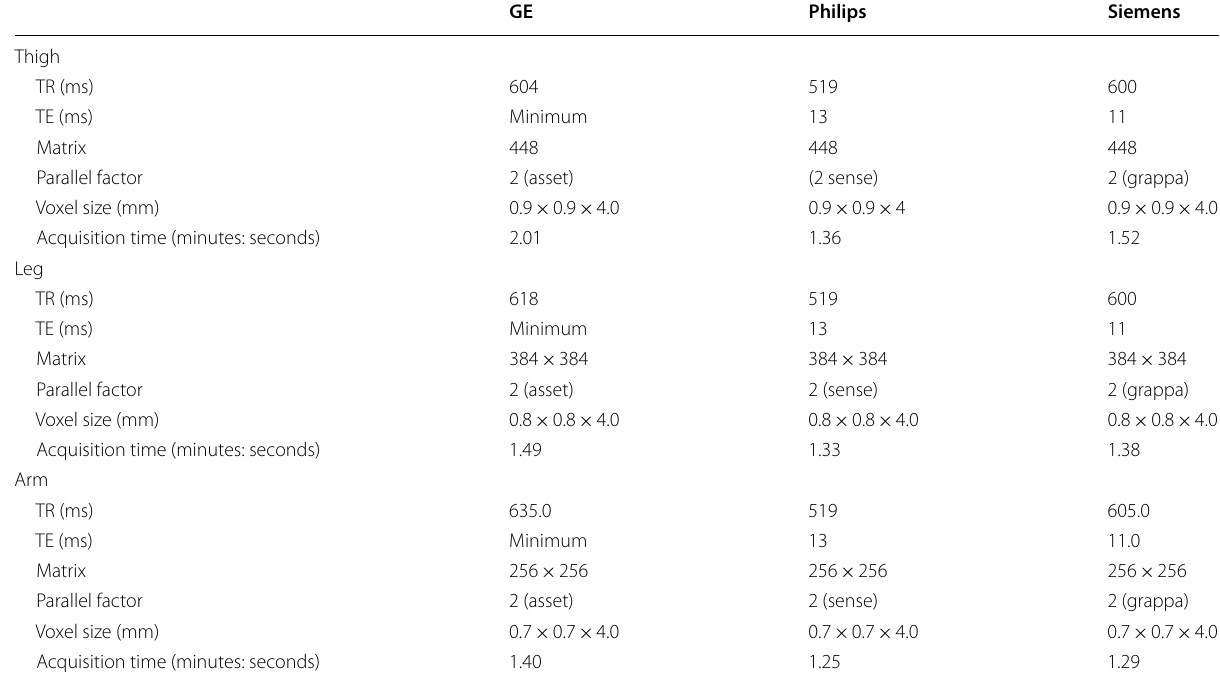
Table 2 T1 TSE acquisition parameters